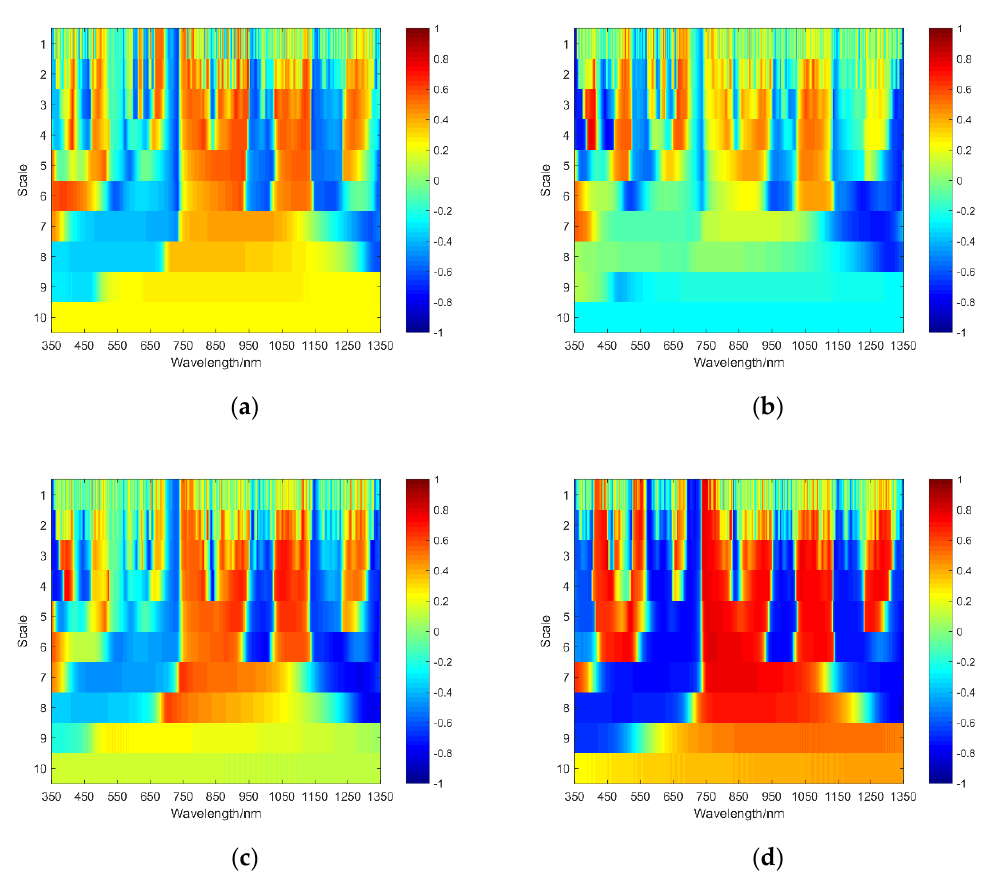
Figure 5. The relevance between the wavelet coefficient of different growth periods and LWC. ( a ) Jointing period; ( b ) booting period; ( c ) flowering period; ( d ) filling period.